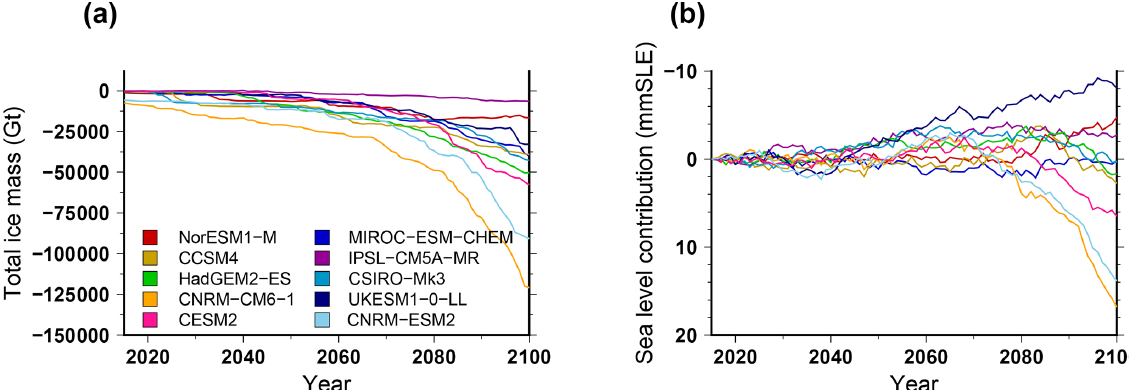
Figure 11. Simulated ice volume difference between the shelf collapse scenario and the standard approach for the projections under different CMIP5 and CMIP6 forcings using the RCP8.5 scenario and SSP585 scenario, respectively. The volume change is expressed as (a) total ice mass change and (b) ice volume contributing to sea level rise. The projection experiments shown in this figure use the medium oceanic